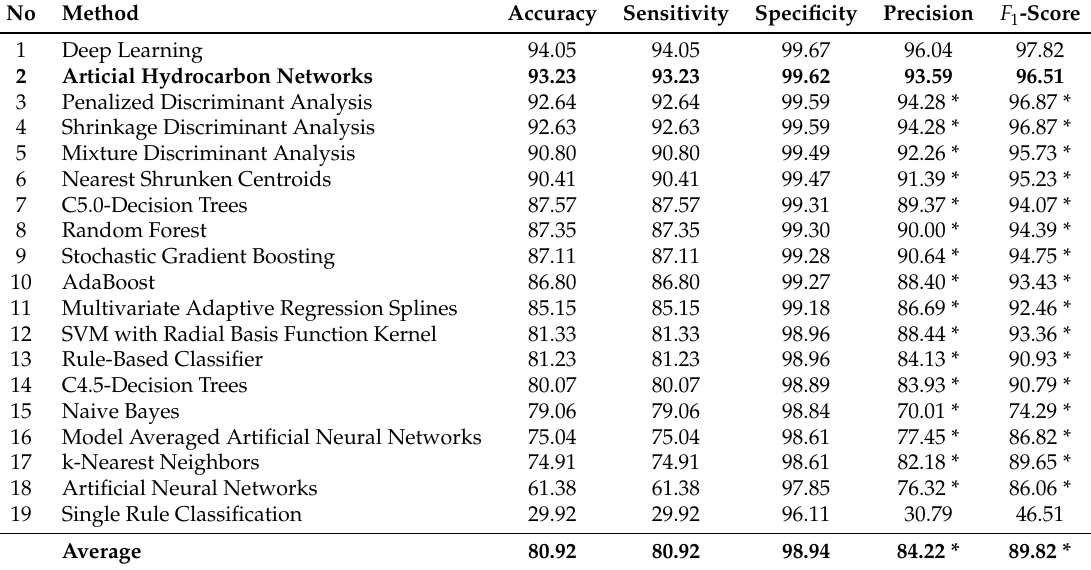
Table 7. Results of case 2: Leave-one subject-out overall performance for the user-independent approach. Values with (*) were obtained using only available metrics when they can be performed over results.